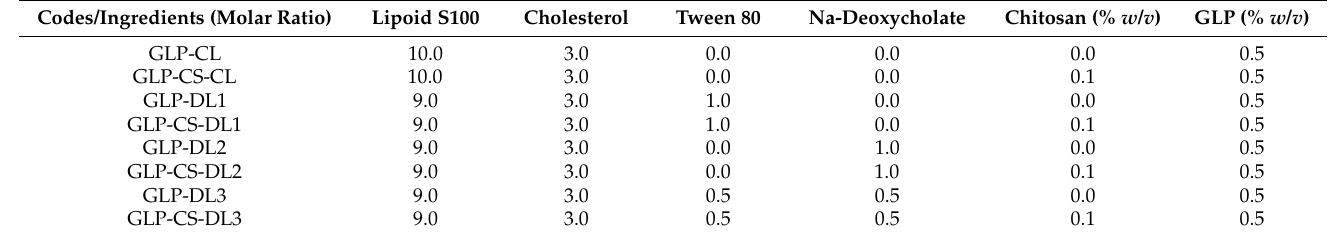
Table 1. The composition of different types of CL-, DL-, and CS-coated liposomes containing GLP. Codes/Ingredients (Molar